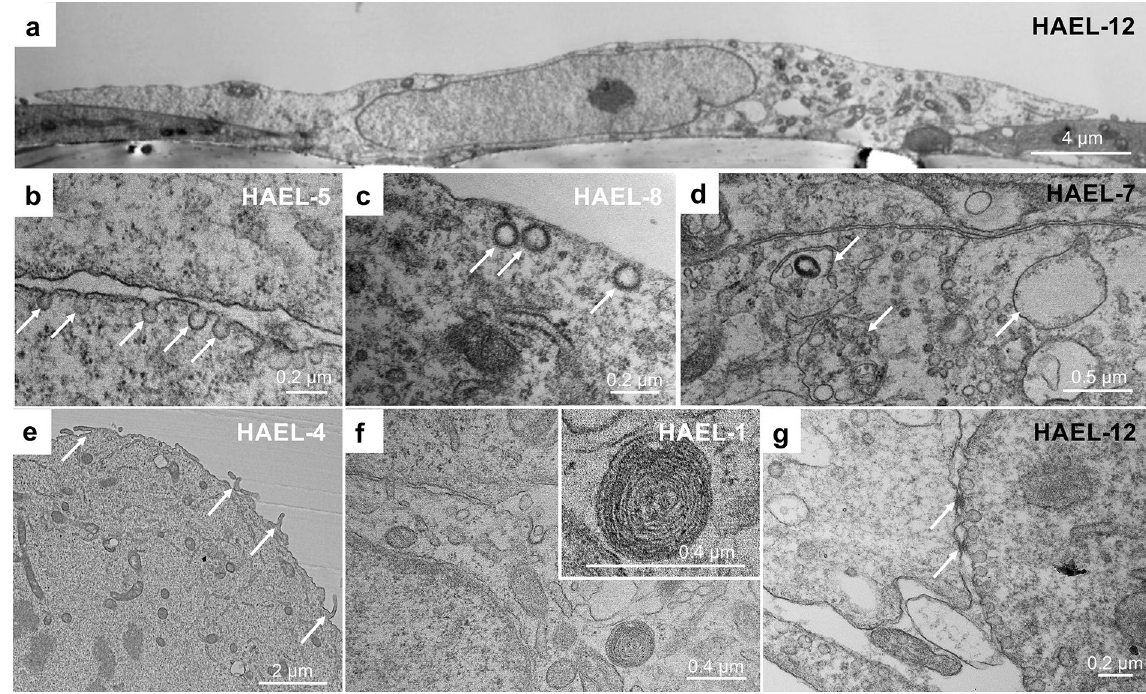
Figure 6. TEM images of ICs showing a flattened thin morphology ( a ), membrane invaginations (caveolae, arrows) ( b ), clathrin-coated vesicles (arrows) ( c ) and numerous endosomal vesicles (arrows) ( d ). Some cells showed a different morphology with the presence of apical microvilli (arrows) ( e ), cytoplasmic inclusions resembling lamellar bodies ( f ) and tight junctions ( g ).